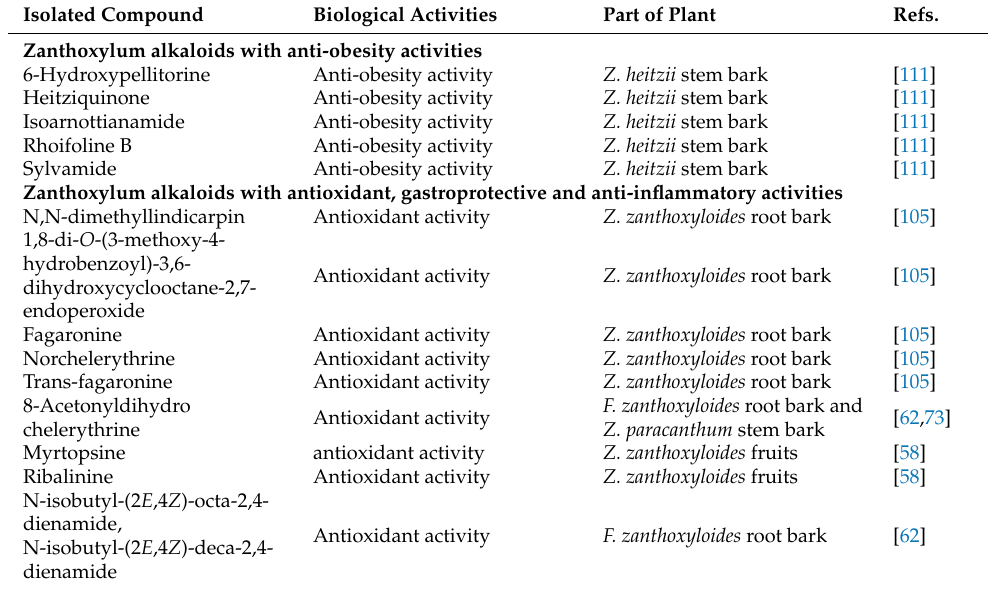
Table 2. Alkaloidal compounds isolated from Zanthoxylum species with their biological activities. Isolated